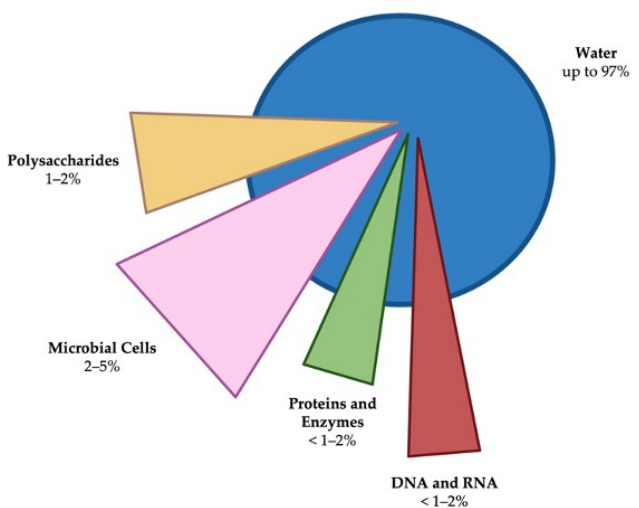
Figure 1. Major components of a biofilm and their typical levels.